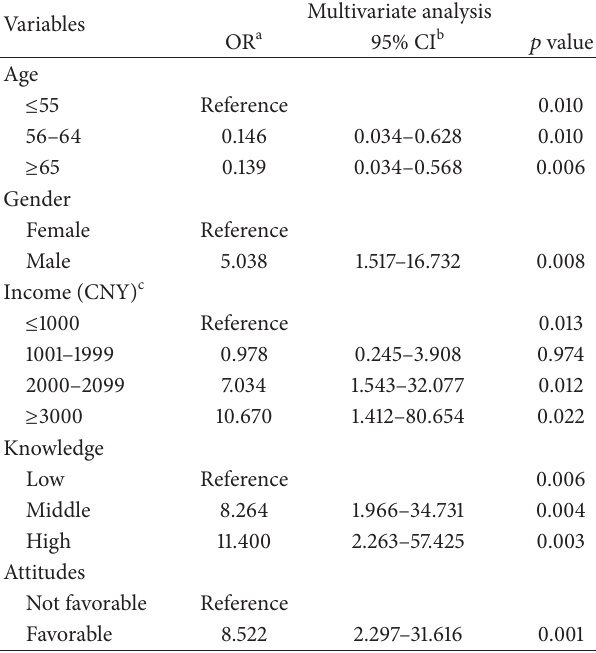
Table 5: Multiple logistic regression